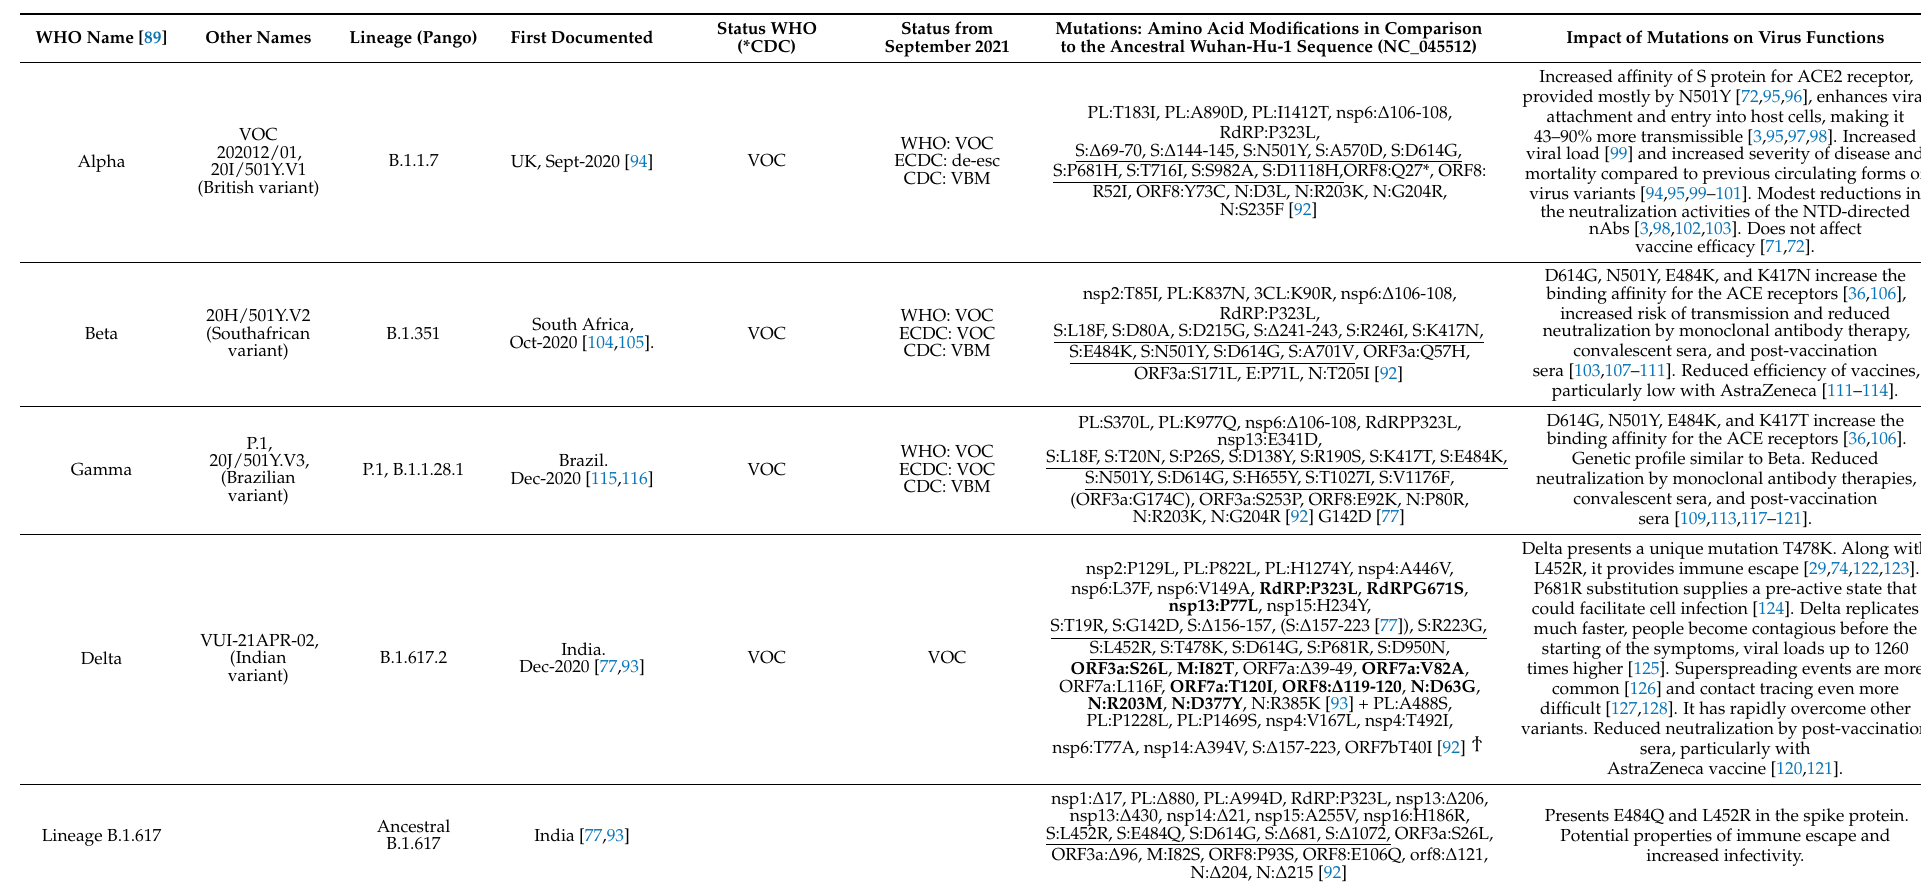
Table 2. Summary of main variants. Name(s), lineage, type, and distinctive mutations of the different variants mapped against the Wuhan-Hu-1 reference sequence (MN908947). The concern status is defined by the WHO [89], the CDC [90], and the ECDC [91]; de-esc: de-escalated. Mutations in the spike gene are